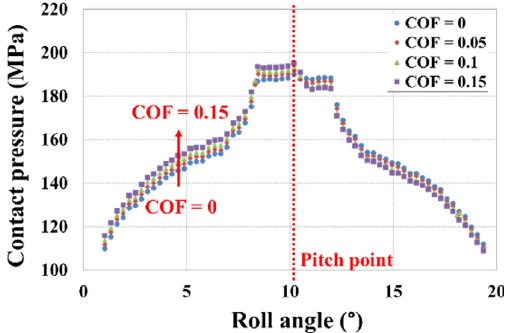
Fig. 5 Highest contact pressure values in each contact position with respect to the COF for a pair of coated gear teeth.